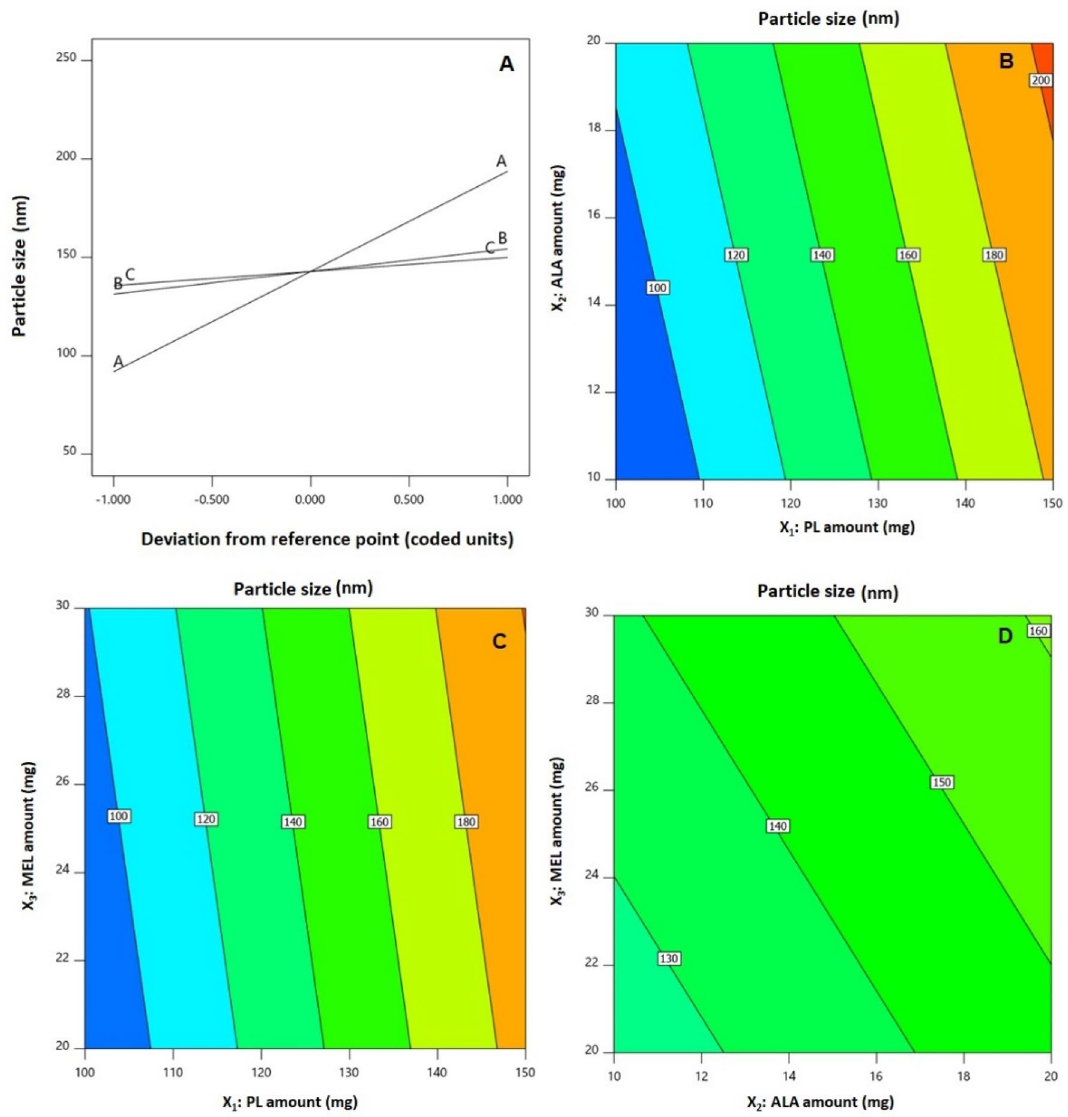
Figure 3. Perturbation plot ( A ) and Contour 2D-plots ( B – D ) showing the effect and interaction between investigated variables on the size of FLV-PL-ALA-MEL